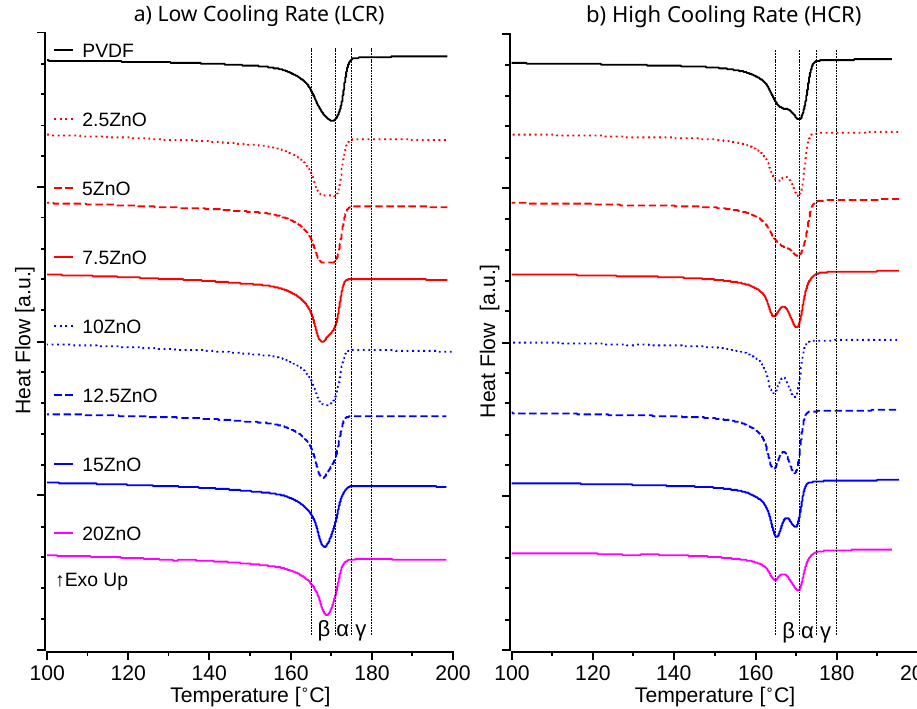
Figure 4. DSC melting temperature for ( a ) 5 °C min − 1 LCR, and ( b ) 30 °C min − 1